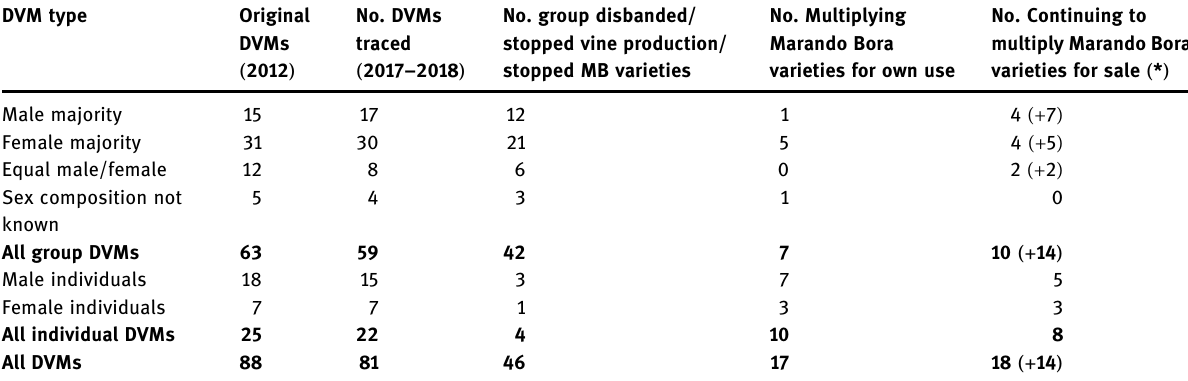
Table 2: Current status of Marando Bora decentralised sweetpotato vine multipliers, Lake Zone, Tanzania, 2016 –